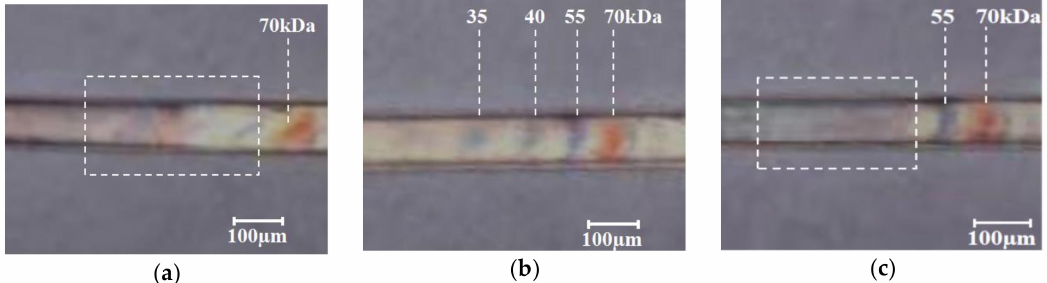
Figure 12. The protein in the microchannels after electrophoresis when melt temperature was: ( a ) 230 ◦ C, ( b ) 250 ◦ C, and ( c ) 270 ◦ C, and the other process parameters were kept at the standard